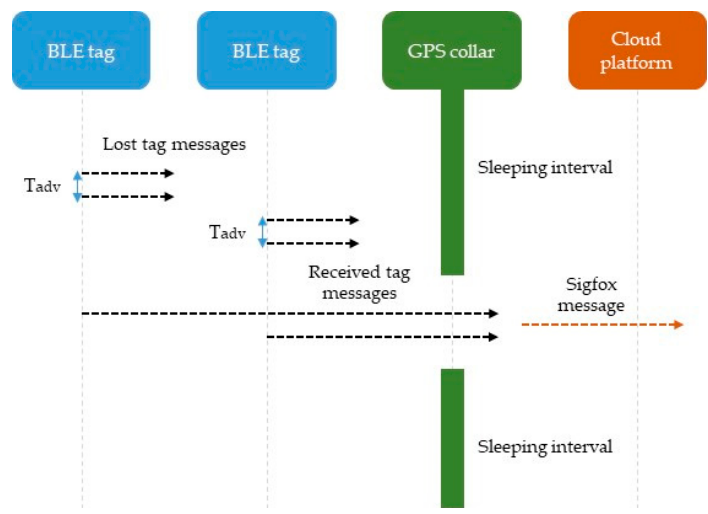
Figure 2. Communication protocol of the proposed solution.